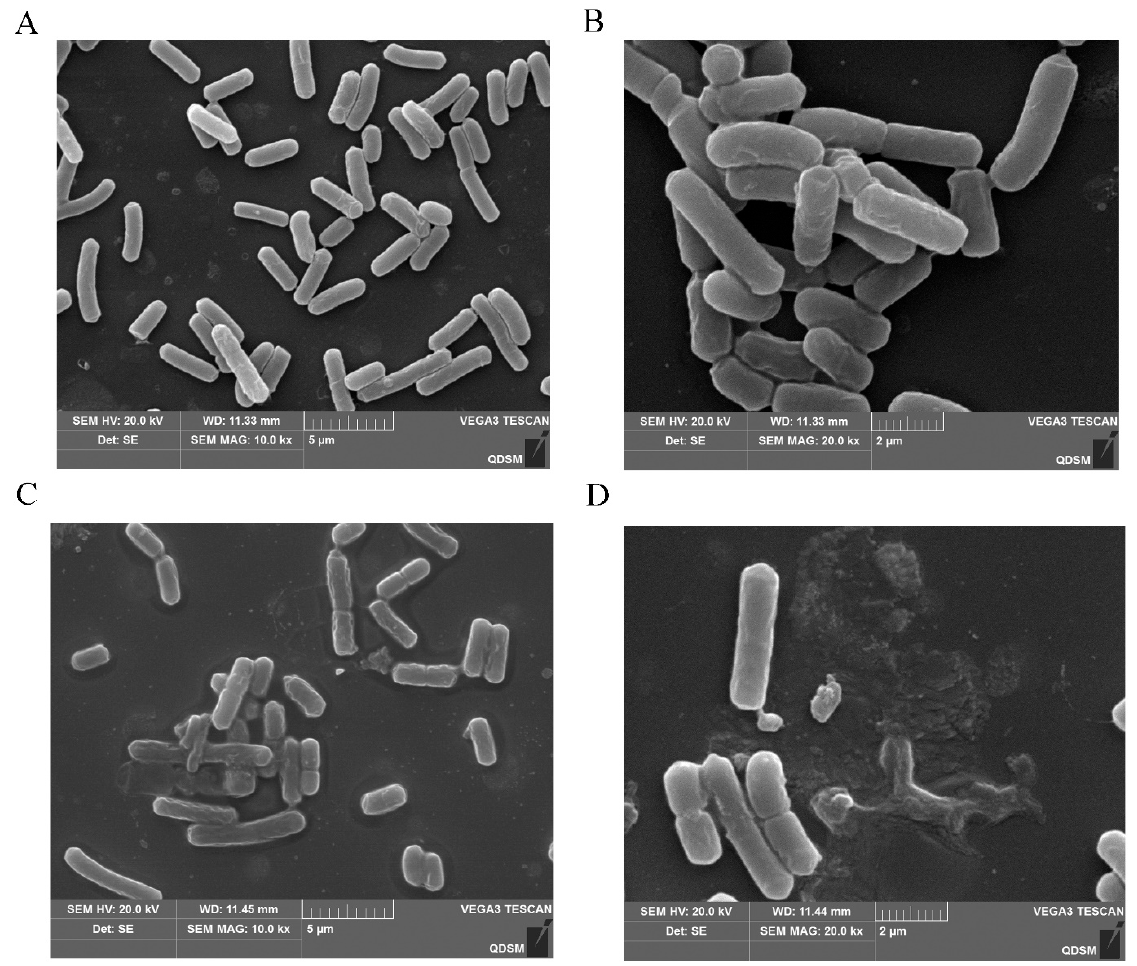
Figure 6. SEM micrographs of C. perfringens CVCC 2032 treated with BMGlv2. ( A , B ) C. perfringens CVCC 2032 treated without BMGlv2, 10.0 Kx and 20.0 Kx. ( C , D ) C. perfringens CVCC 2032 treated with BMGlv2 at MIC for 2 h, 10.0 Kx and 20.0 Kx.